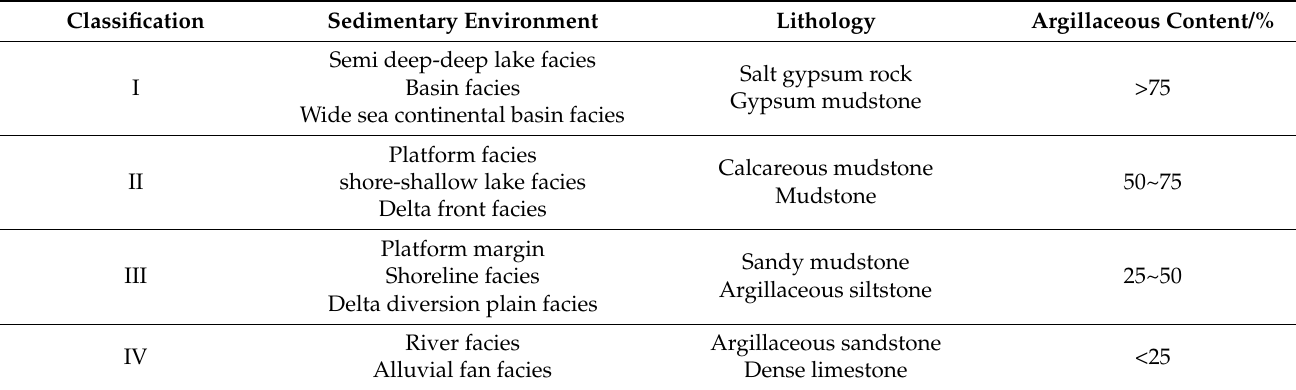
Table 1. Lithology classification of gas storage caprock of depleted gas